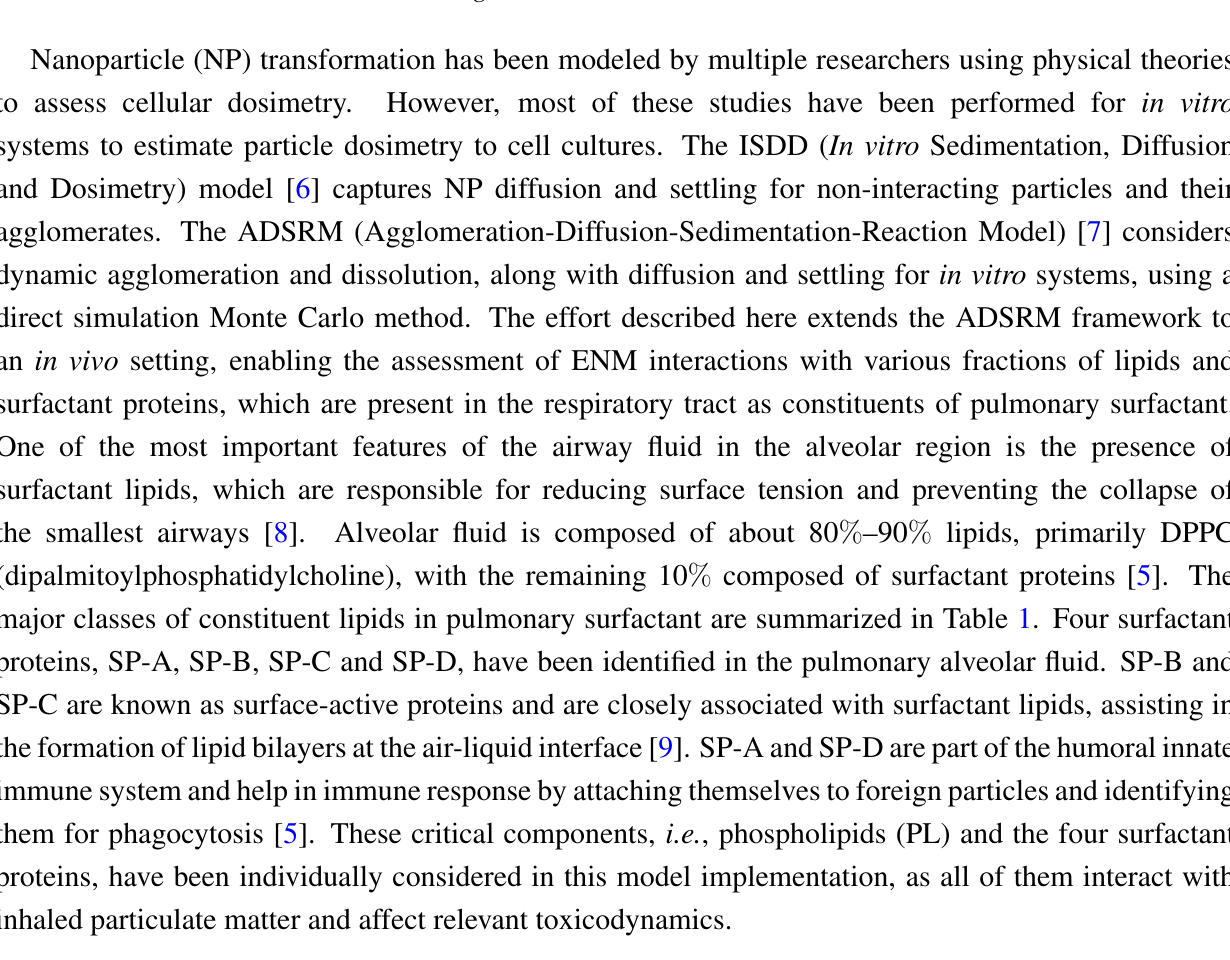
Table 1. Properties of alveolar surfactant